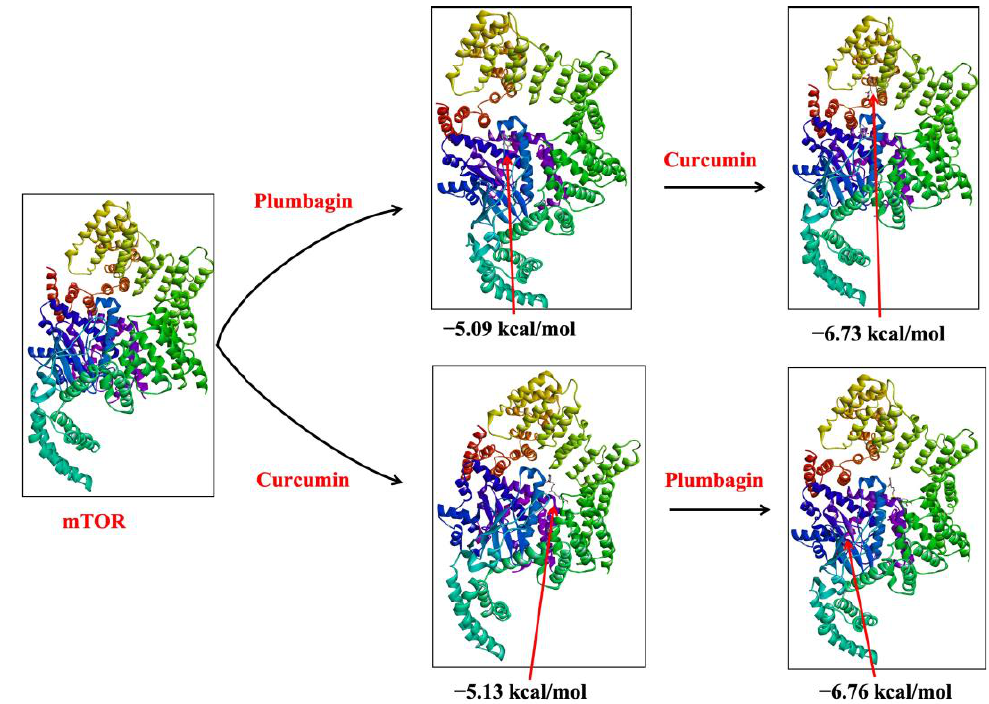
Figure 4. Sequential binding of curcumin and plumbagin after docking against mTOR protein. The red arrows indicate the position of bound ligand on the target protein.